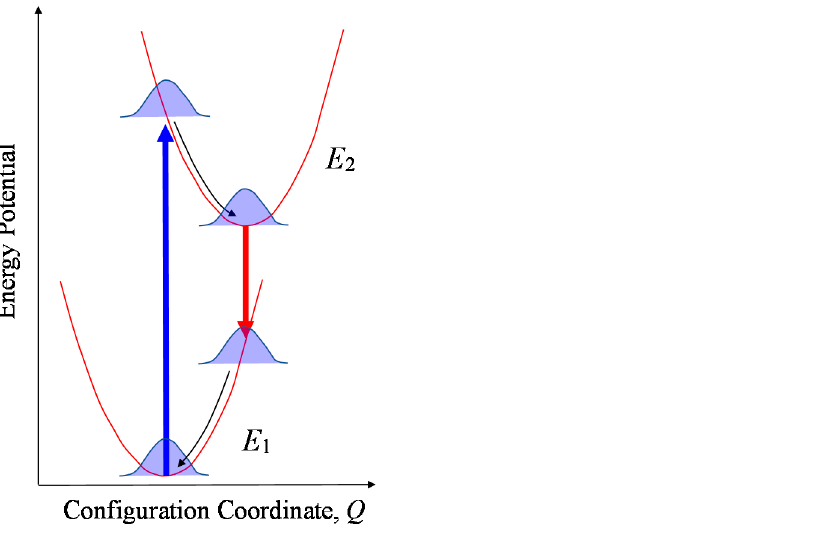
Figure 4. Potential energy curves for the ground state ( E 1 ) and the excited state ( E 2 ) of an atom in a solid. The vertical blue and red arrows depict fast dipole-allowed transitions upward to E 2 and downward to E 1 , respectively, followed by configuration relaxation (black arrows). Because optical transitions take place vertically according to the Franck–Condon Principle, the system is pushed far from equilibrium. The difference in energy between the absorption and emission transitions, known as the Stokes shift, is particularly large in systems that undergo configuration relaxation. The relaxation process is mediated by phonon emission, which causes heating. The Gaussian-shaped curves illustrate the distribution of energy due to the optical